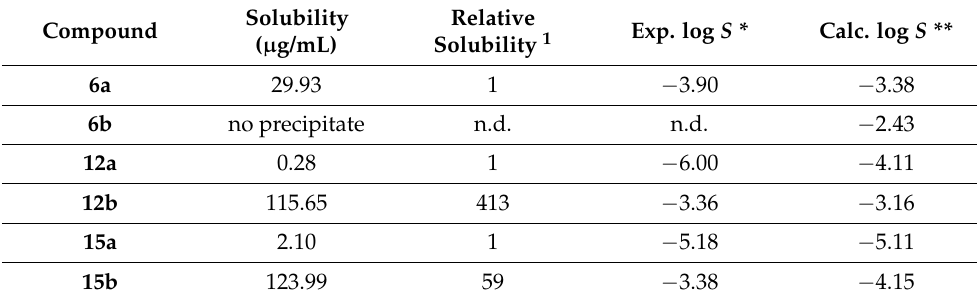
Table 2. Water solubility and log S * of the investigated